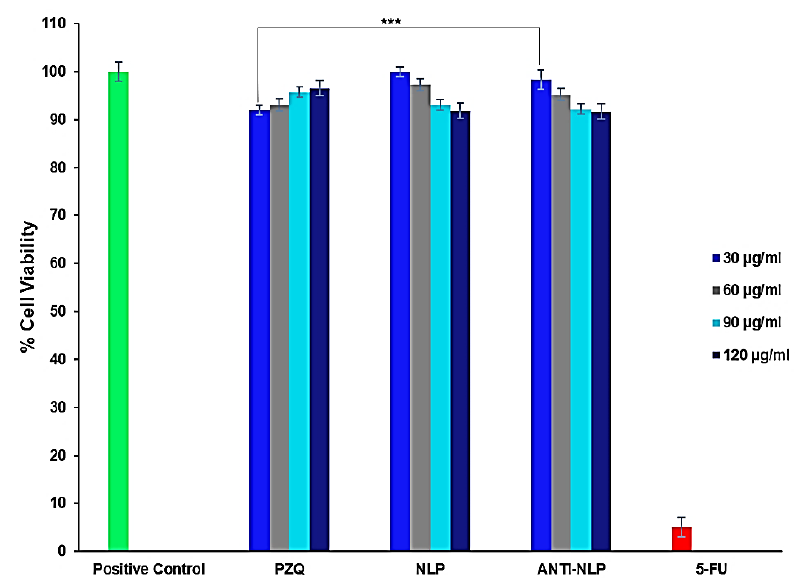
Figure 6. MTT assay measurement of the viability of RAW 264.7 murine macrophage cells after 24 h treatment with free PZQ, NLP, and anti-calpain-NLP at different concentrations (Data represent n = 3, mean ± SD). Positive control is the untreated group used to compute the percentage of cell viability. *** indicates p < 0.0001 when compared to the NLP and anti-calpain-NLP groups with the same concentration of PZQ.